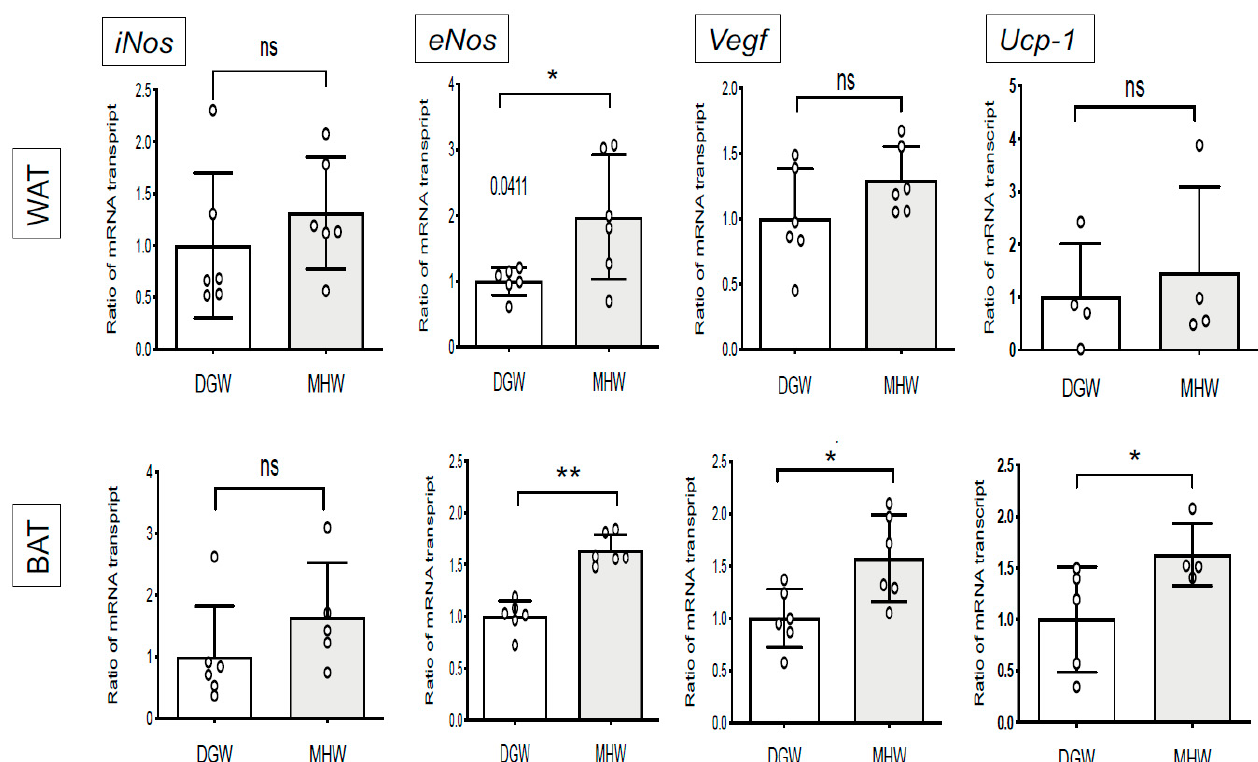
Figure 4. The genes expressed in BAT of DIO mice drinking MHW vs DGW for 2 weeks. Y-axis indicates the transcriptional Figure 4 . The genes expressed in BAT of DIO mice drinking MHW vs DGW for 2 weeks. Y ‐ axis indicates the transcriptional ratio of expressing genes ( eNos , Vegf , or Ucp-1 ) in WAT or BAT of DIO mice drinking MHW compared with DGW. The bar ratio of expressing genes ( eNos , Vegf , or Ucp ‐ 1 ) in WAT or BAT of DIO mice drinking MHW compared with DGW. The bar graphs show mean ± SD. * p < 0.05, ** p < 0.01; ns, not graphs show mean ± SD. * p < 0.05 , ** p < 0.01; ns, not significant.